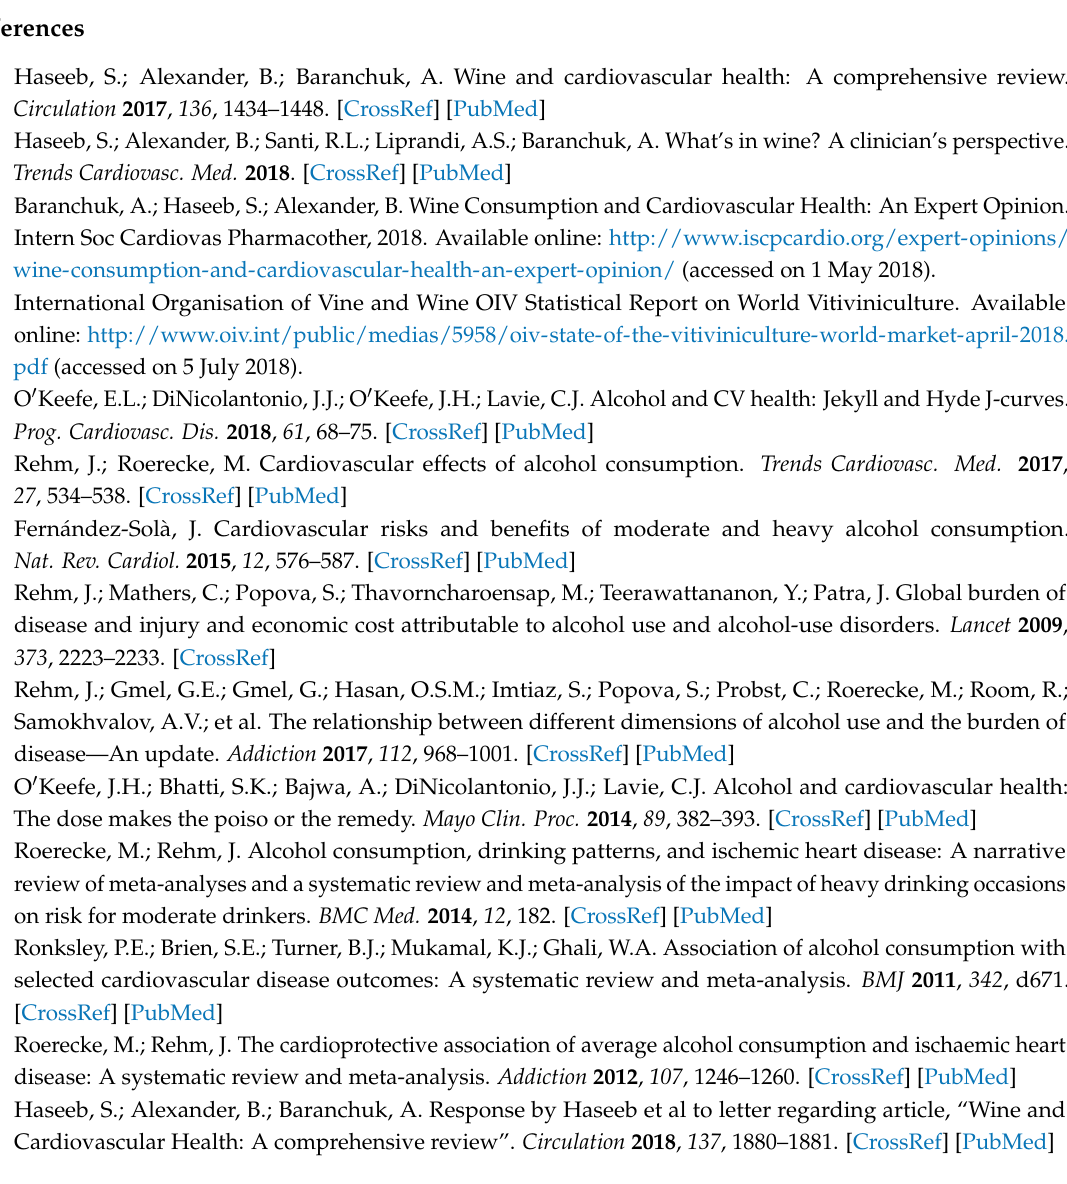
Supplementary Materials: The following are available online. Table S1: Characteristics of study participants stratified by